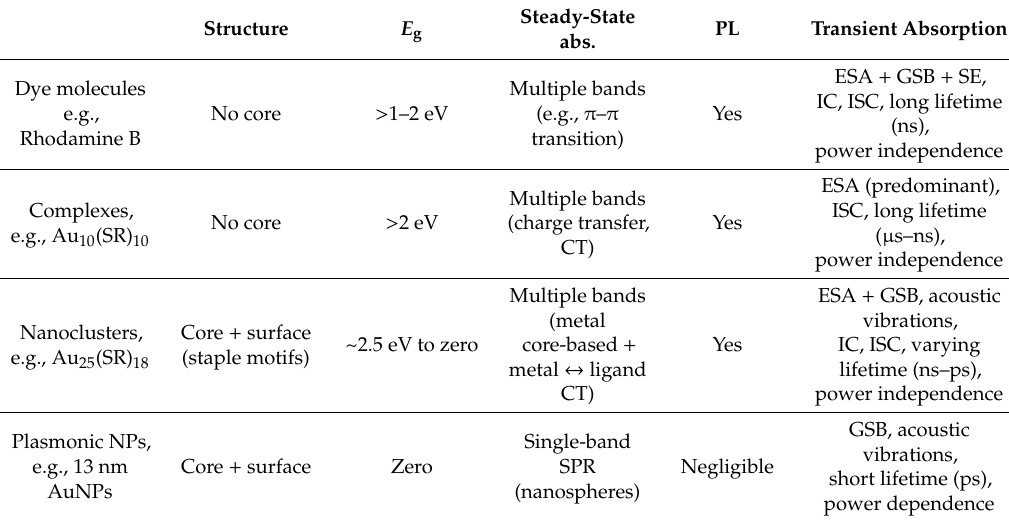
Figure 8. ( A ) Kinetic traces probe at 520 nm with different pump fluences; ( B ) electron–phonon time constants as a function of pump fluence. Table 1. Characteristic features of molecules, complexes, nanoclusters, and plasmonic nanoparticles (PL: photoluminescence; ESA: excited state absorption; GSB: ground-state bleach; SE: stimulated emission; IC: internal conversion; ISC: intersystem crossing).